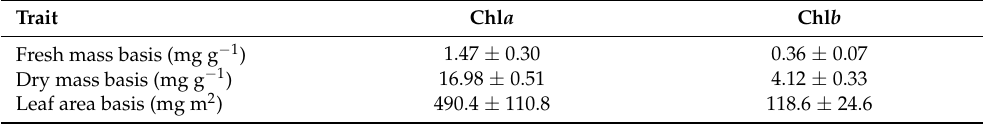
Table 10. Mean values ( ± SE) of chlorophyll content on fresh mass, dry mass and leaf area basis of Picris willkommii leaves. Sample size = 4. Leaves of 15–22 cm 2 were used. Trait Chl a Chl b Fresh mass basis (mg g − 1